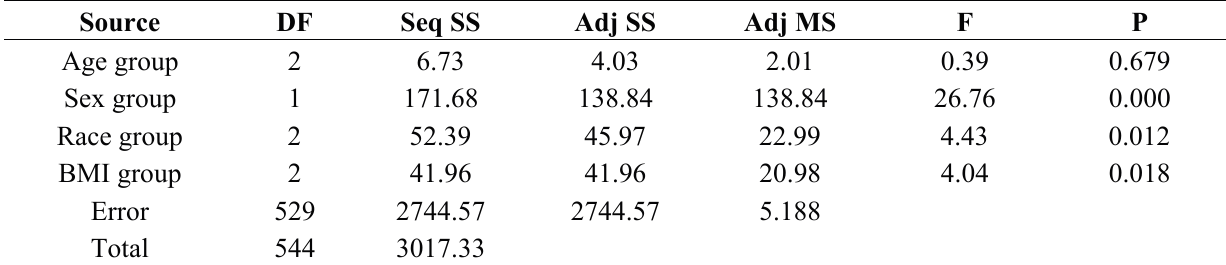
Table 8. Statistical variables from subgroup analysis for estimated and target skeletal muscle